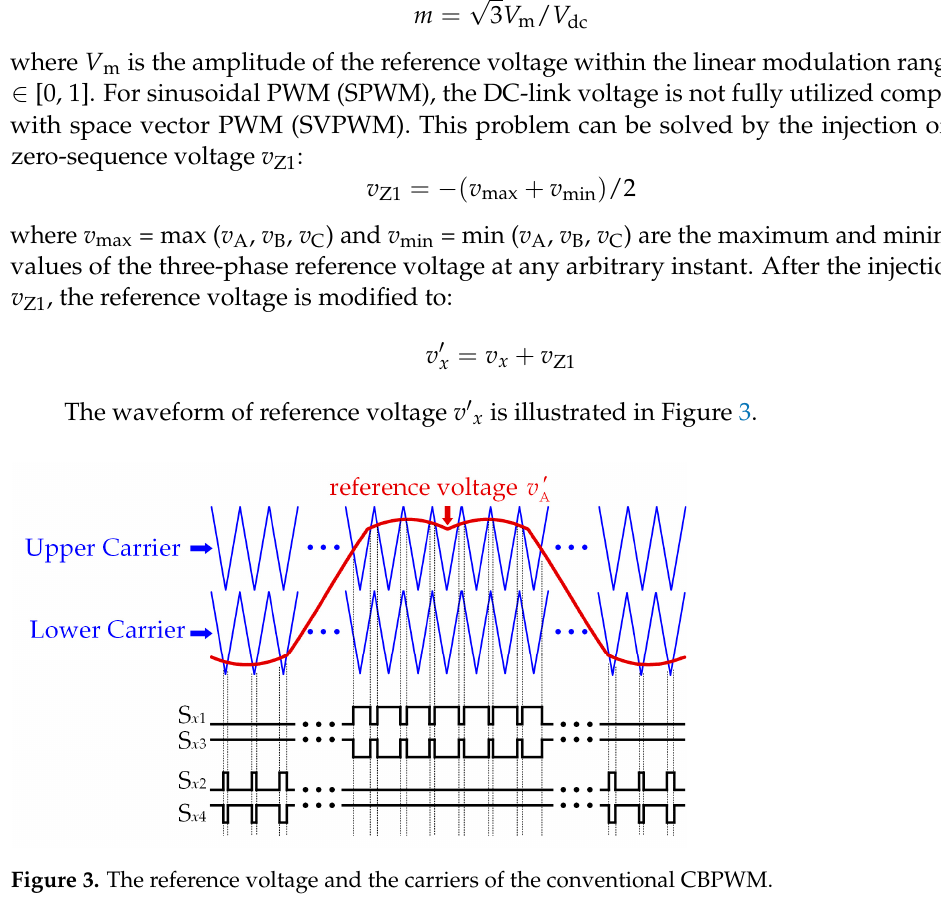
carrier period is shown in Figure 4.